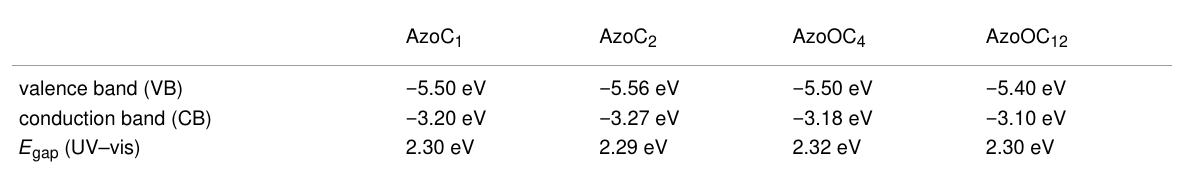
Table 3: Relative energies of VB and CB, determined by using a combination of UV–vis direct reflection and PESA of all functionalized particles. All spectra can be found in Supporting Information File 1, Figure